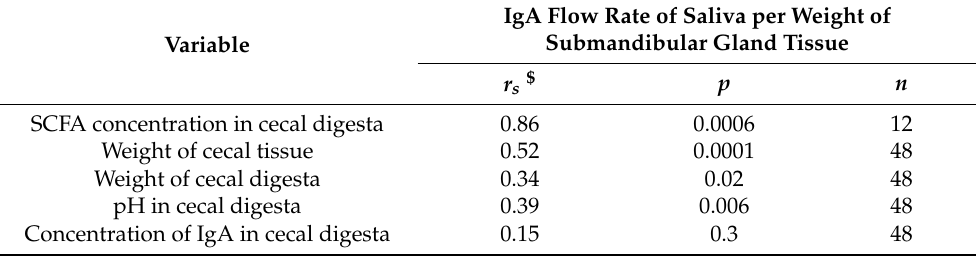
Table 3. Correlation between IgA flow rate of saliva per weight of submandibular gland tissue and concentration of short-chain fatty acids (SCFA) in cecal digesta, weight of cecal tissue, weight of cecal digesta, pH in cecal digesta, or concentration of IgA in cecal digesta.